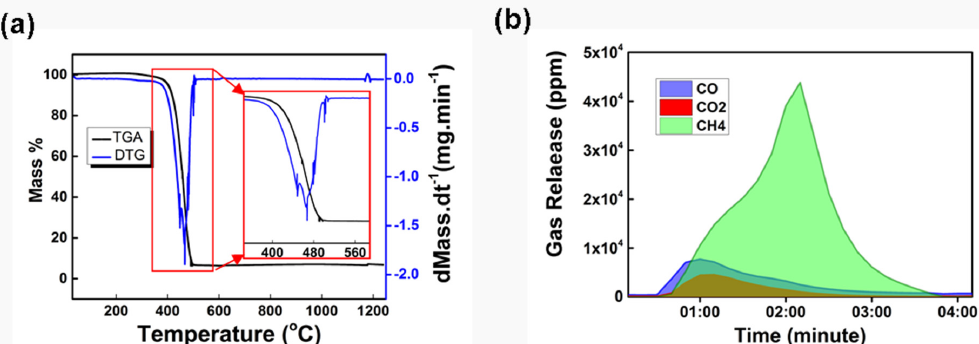
Figure 3. ( a ) TGA-DTG curve for the snack packaging plastics waste. ( b ) IR gas analysis for the gases emission from plastic waste at 1200 °C.